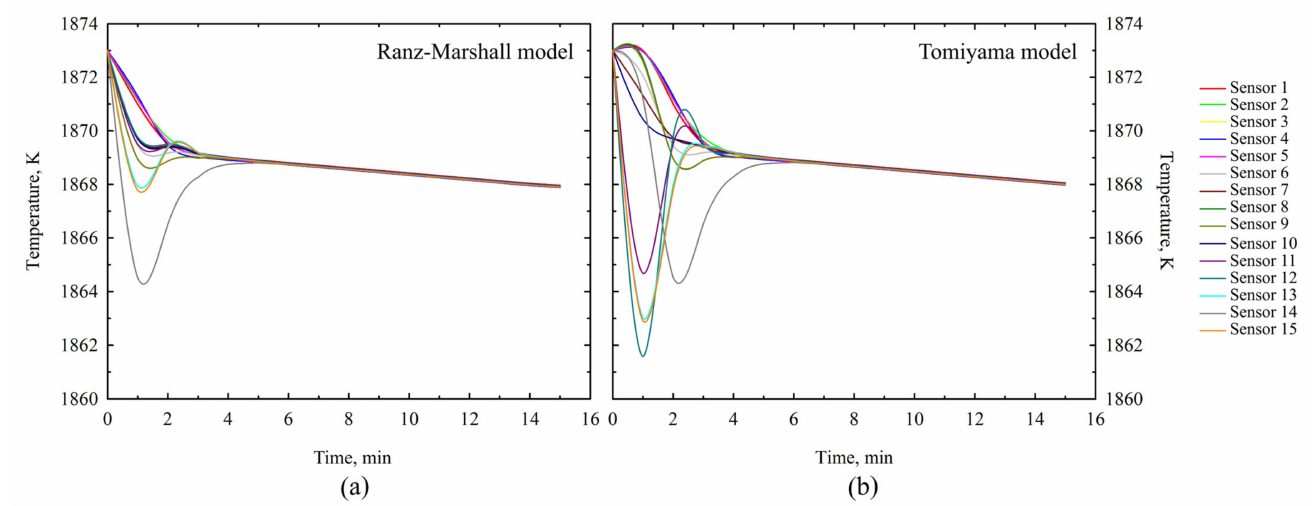
Figure 6. Steel temperature behavior by running ( a ) Ranz-Marshall and ( b ) Tomiyama